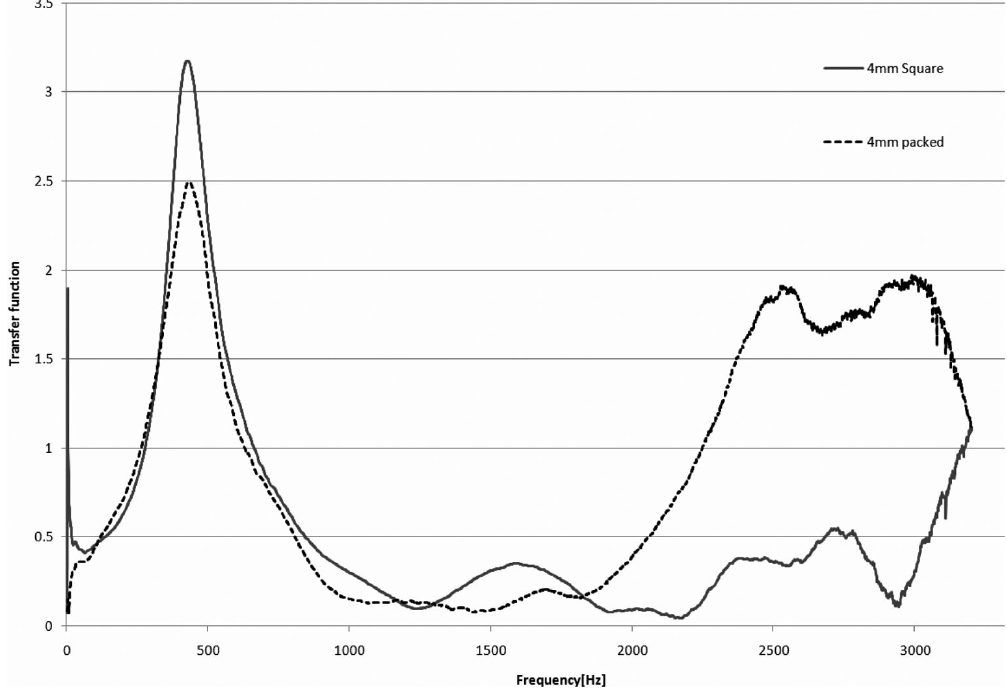
Fig. 66. EIDL Transmissibility curves – 4 mm Packed vs. 4 mm